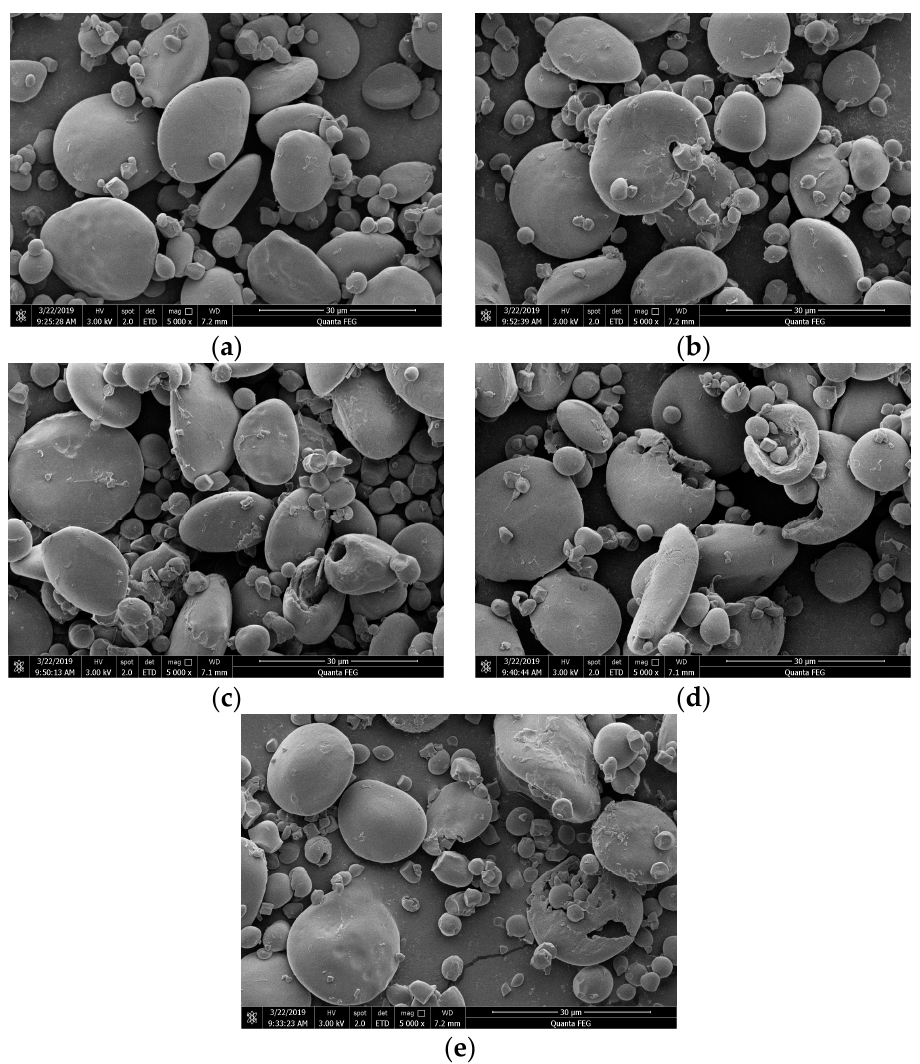
Figure 2. Scanning electron microphotographs of starches separated from bifidobacteria-fermented dough at different fermentation times: ( a ) 0 h, ( b ) 2 h, ( c ) 6 h, ( d ) 9 h, ( e ) 12 h.